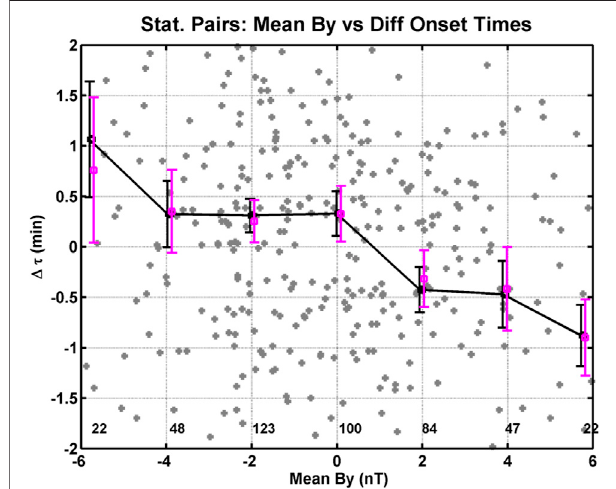
FIGURE 11 | Difference in onset time determined from the cross covariance method versus the difference in onset time determined from the by-eye method. The gray points are individual events, and the black line is a linear fi t to the data. The fi t to the data is given in the upper left corner.